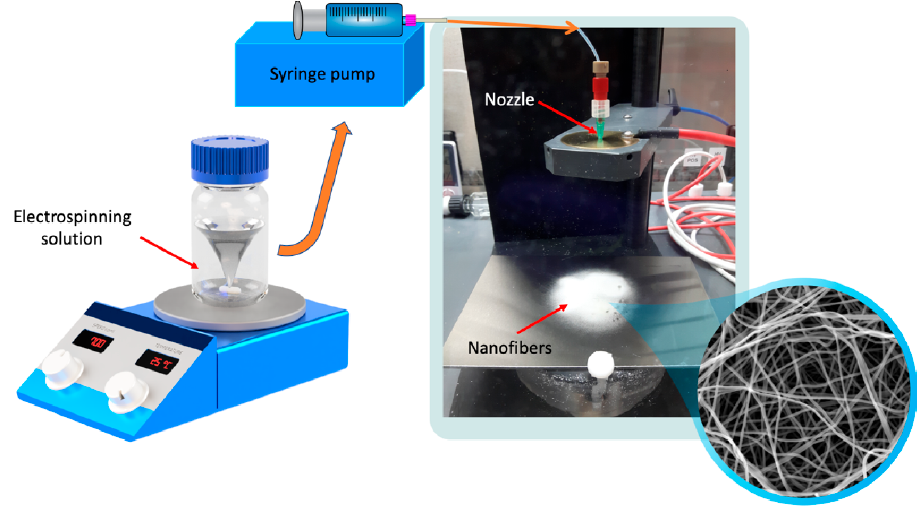
Figure 1. Preparation of ciprofloxacin-loaded